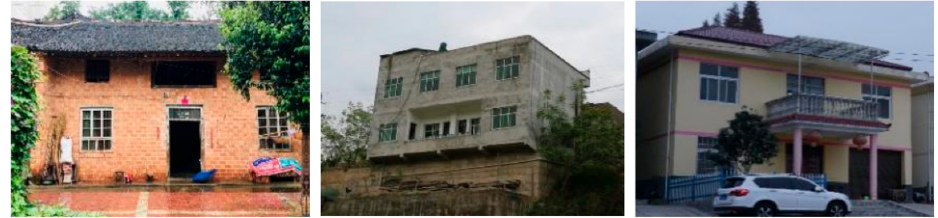
Figure 1. Typical forms of modern rural houses in Hanzhong [32].